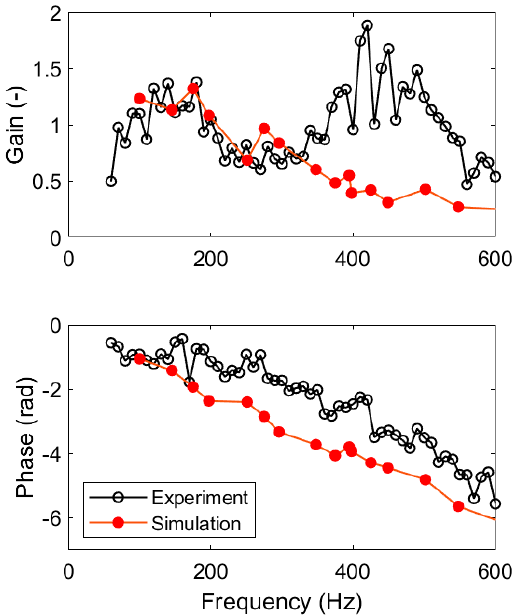
Figure 9. Measured and predicted flame transfer function.